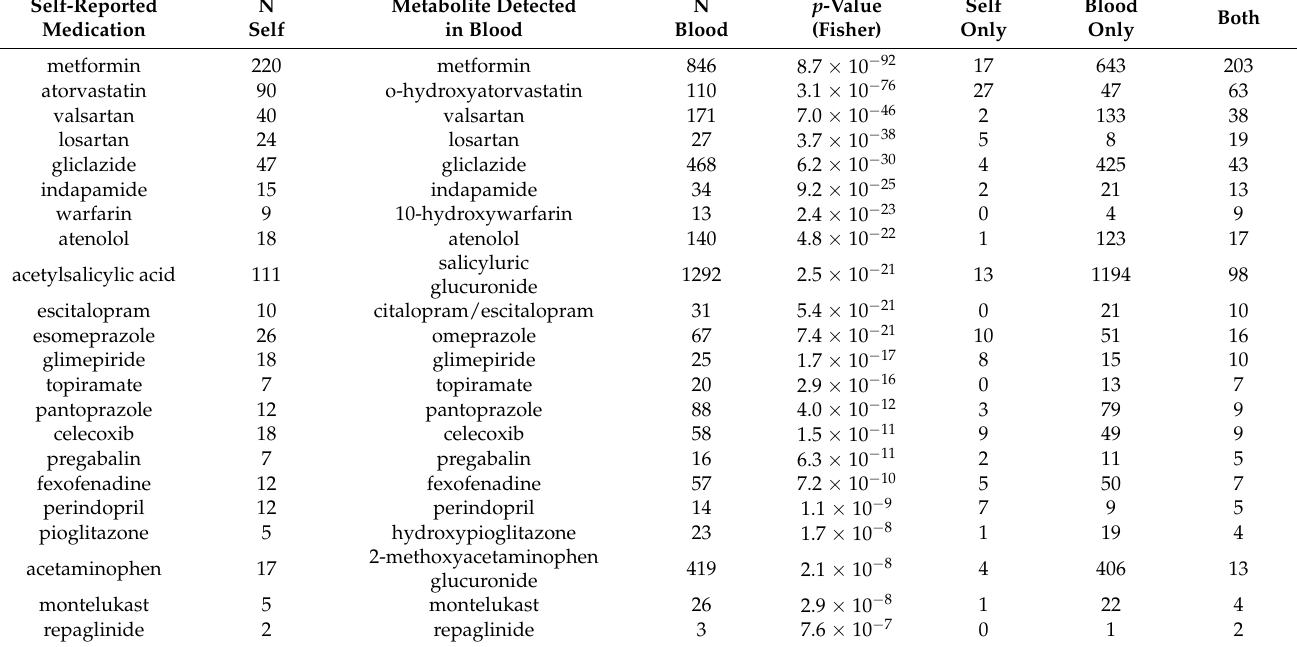
Table 3. Self-reported medication (N self) and drug metabolites detected in blood (N blood); The total number of samples in this analysis was N = 2807. Included are all mutual best-hits with Bonferroni- significant associations (Fisher test, p -value < 0.05/N-self-reported/N-detected = 0.05/394/119 = 1.1 × 10 − 6 ). All pairwise associations that reached nominal significance ( p < 0.05) are in Supplementary Table